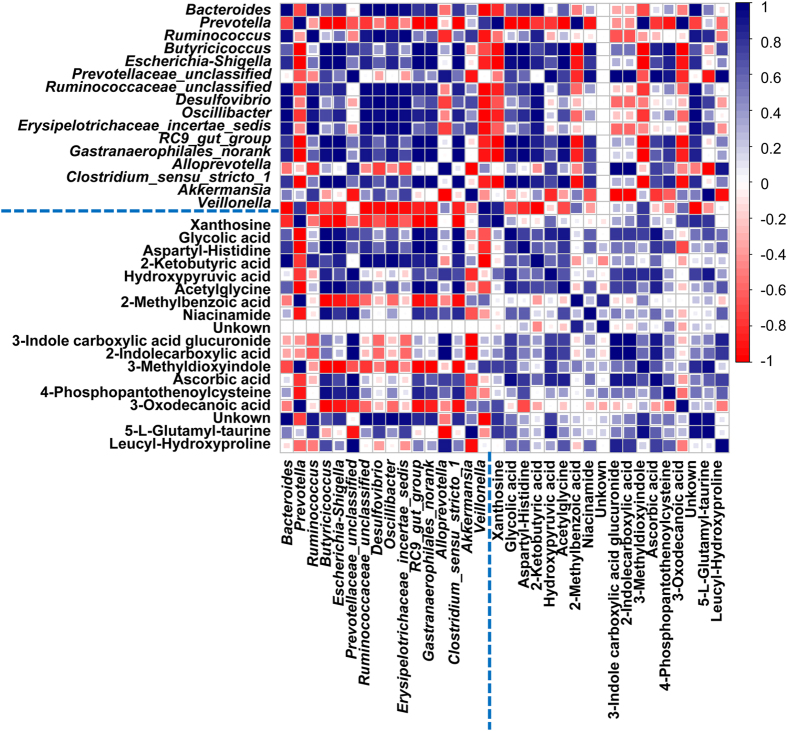
A correlation heatmap is used to represent significant statistical correlation values (r) between perturbed gut microbiota genera and altered urinary metabolites in antibiotic group and control group.Blue squares indicate significant positive correlations (r > 0.5, p < 0.05), white squares indicate nonsignificant correlations (p > 0.05), and red squares indicate significant negative correlations (r < −0.5, p < 0.05).